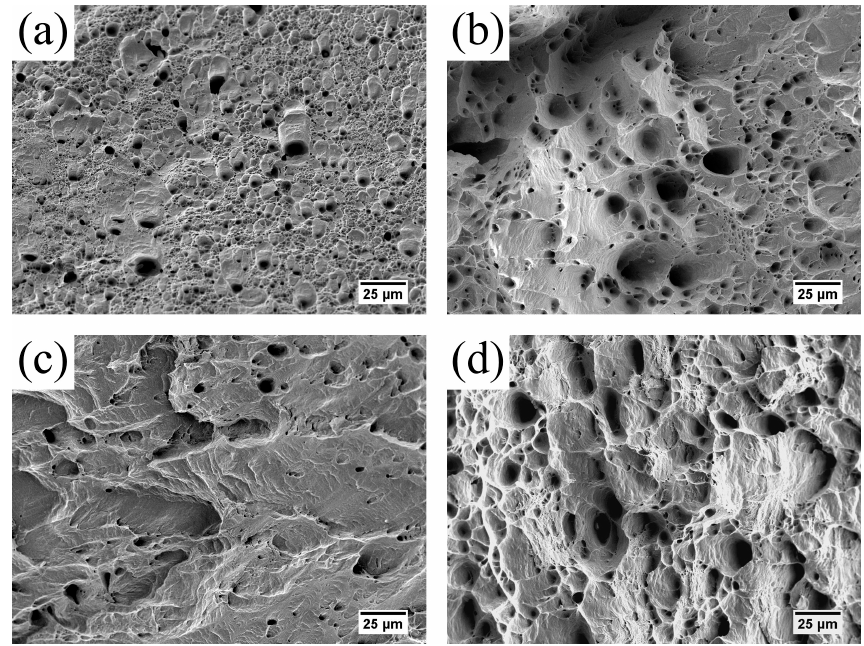
Figure 11. Fractographic image of Z3CN20.09M CDSS with different tensile conditions. ( a ) The “as received, 20 °C” condition; ( b ) the “as received, 320 °C” condition; ( c ) the “aged 2000 h, 320 °C” condition; ( d ) the “annealed 3 h, 320 °C” condition. Figures are imaged by SEM after tensile tests.